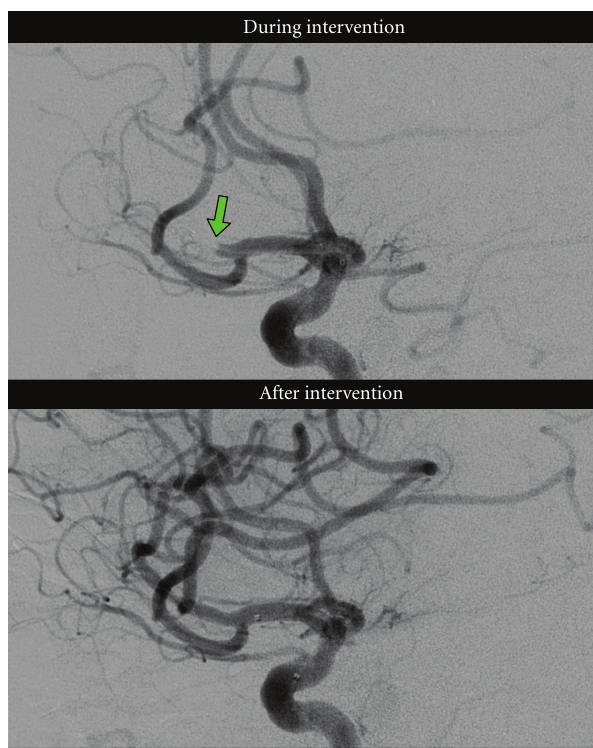
Figure 3: Case 1: DSA images from the right anterior cerebral circulation. The microcatheter is seen in an occluded M2-segment of the right MCA (arrow) during the intervention. The IA- thrombolysis results in complete recanalization of the occluded segment.